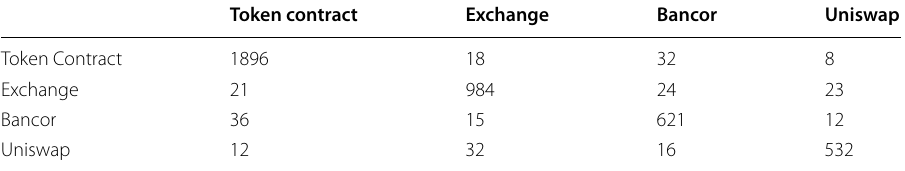
Table 13 Confusion matrix of our classification algorithm with an exhaustive examination of all the possible weight combinations for the Eros distance Token contract Exchange Bancor Uniswap Token Contract